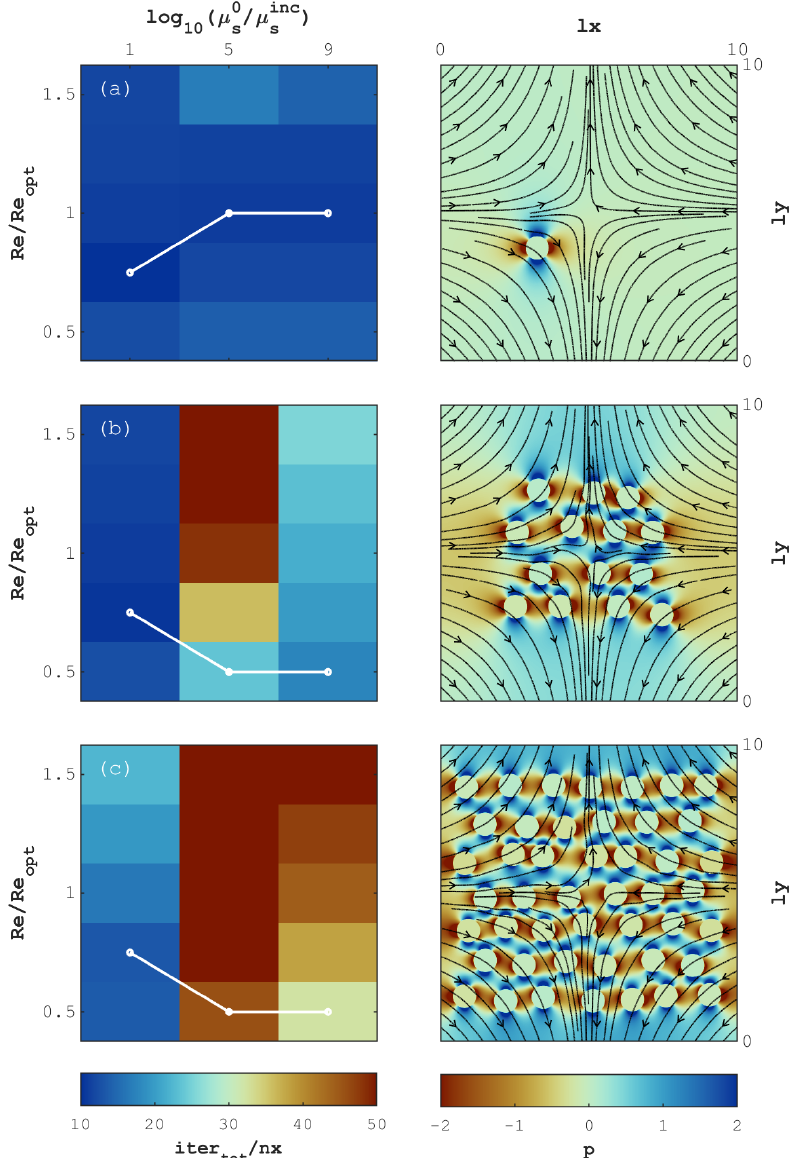
Figure 12. Pure shear-driven flow. The left column reports the number of iterations for different values of viscosity ratio µ 0 s /µ inc s and ratio of numerical Reynolds number Re to the theoretically predicted value Re opt . Connected white dots indicate the value of Re at which the minimal number of iterations is achieved. The right column depicts the distribution of pressure and velocity streamlines. Panels (a) , (b) and (c) correspond to problem configurations involving 1, 14 and 46 inclusions,